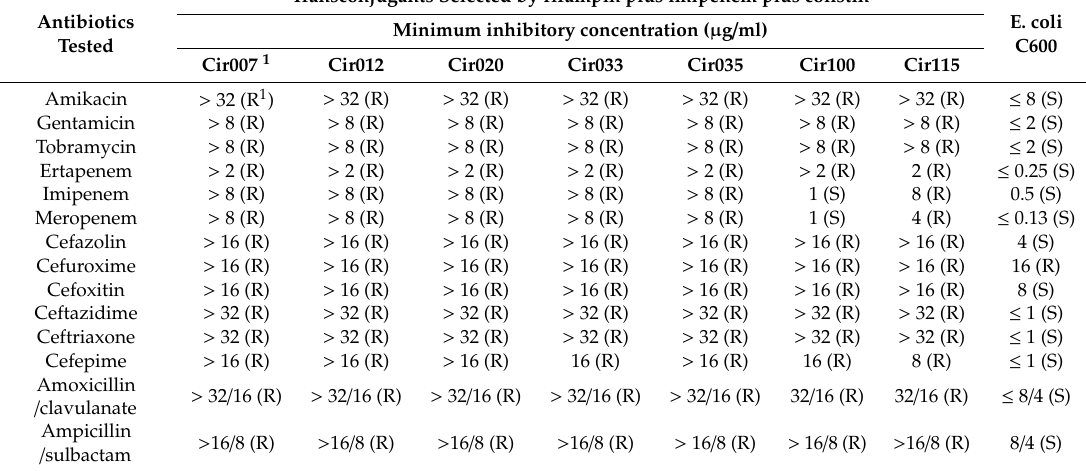
Table 1. Phenotypic characteristics of the transconjugants of the eight carbapenem-resistant and colistin-resistant E.